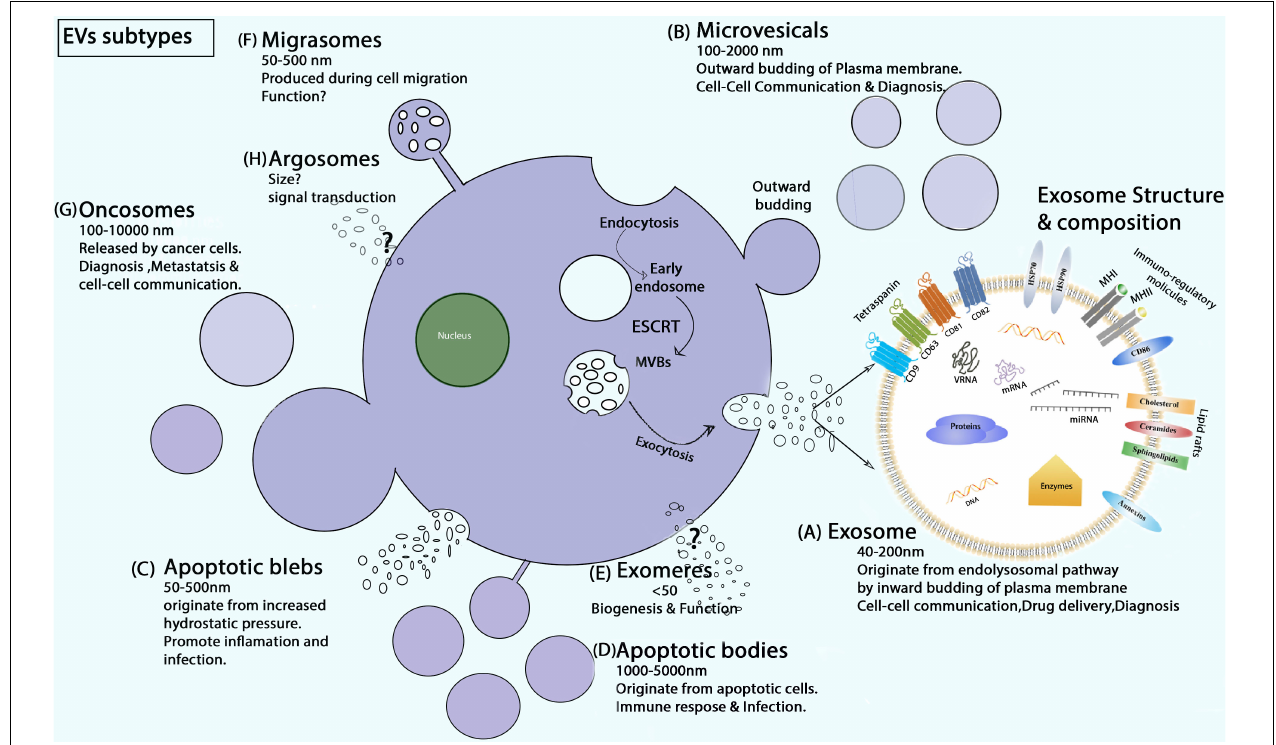
FIGURE 1 | Schematic of EV biogenesis and subtypes. (A) Exosome secretion (ESCRT dependent) and composition. (B) MVs are formed during inflammatory and hypoxic conditions as buds off of the plasma membrane. (C) Apoptotic blebs are EVs that generate with increased cell contraction and hydrostatic pressure (Xie et al., 2020). (D) Apoptotic bodies are released only during programmed cell death (Jadli et al., 2020). (E) Exomeres are recently discovered EVs, and their biological function and biogenesis is yet unknown (Zhang et al., 2018; Xie et al., 2020). (F) Migrasomes are oval-shaped EVs produced during cell migration. (G) Oncosomes are membrane-derived large and small EVs released by cancer cells. They contain a unique signature of the tumor cells from which they are secreted (Chuo et al., 2018). (H) Argosomes are exosome-like vesicles, and their biogenesis starts from the basolateral membrane of Drosophila discoid cells and can take part directly in the transferring of molecules from producer to recipient cells (Borges et al., 2013).